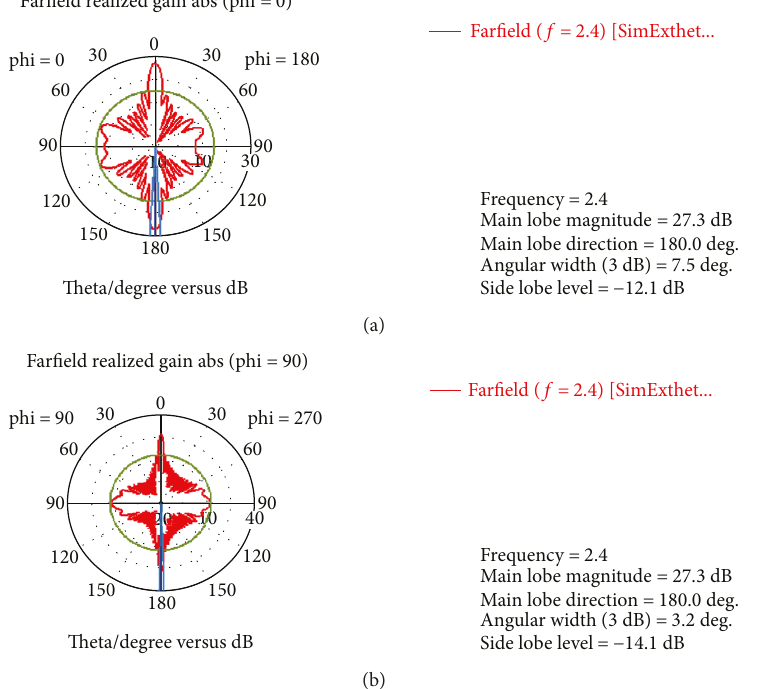
Figure 7: (a) 2D model of gain radiation pattern of the 128-antenna array at phi =0deg. (b) 2D model of gain radiation pattern of the 128-antenna array at phi=90 deg.